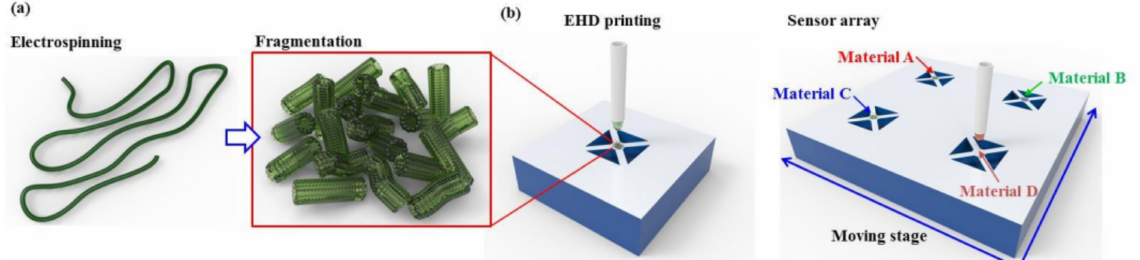
Figure 37. Fabrication of highly integrated gas sensor array by EHD printing of electrospun nanofibers: ( a ) metal oxide nanofiber fragments are prepared by electrospinning and fragmentation process (e.g., ultrasonication); ( b ) individual gas sensor and highly integrated gas sensor array were fabricated by micro-patterning of heterogeneous metal oxide nanofibers via sequential or parallel EHD printing process. Reprinted with permission from [372]. Copyright 2017